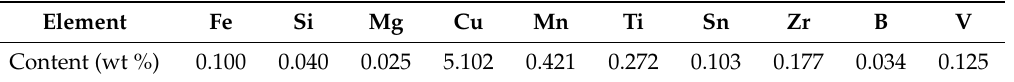
Table 1. Chemical composition of the raw material.